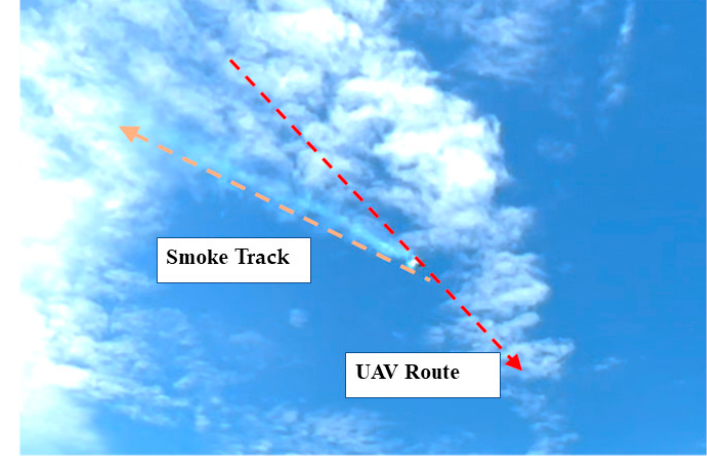
Figure 11. Smoke track correction without the AI model.